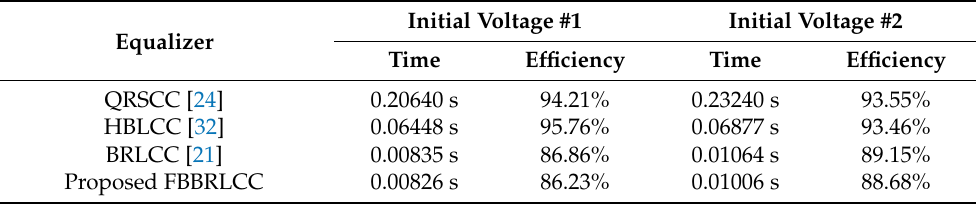
Figure 7. Voltage trajectories of different equalizers with initial voltages #1 and #2. ( a , b ) QRSCC. ( c , d ) BRLCC. ( e , f ) HBLCC. ( g , h ) Proposed FBBRLCC. Table 1. Simulation comparison of different equalizers with initial voltages #1 and